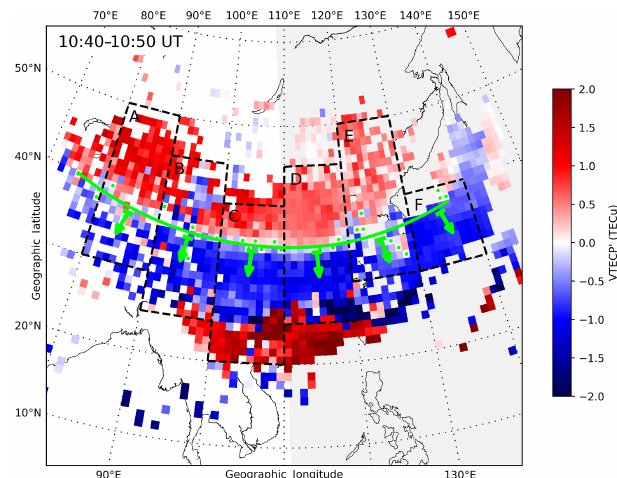
Figure 7. A detailed example of the wavefront fitting method. Green dots indicate the data points for least-square fitting. Green arrows depict the propagation orientations in different longitudes. Dashed black rectangles mark the areas for generating TLPs in Fig.